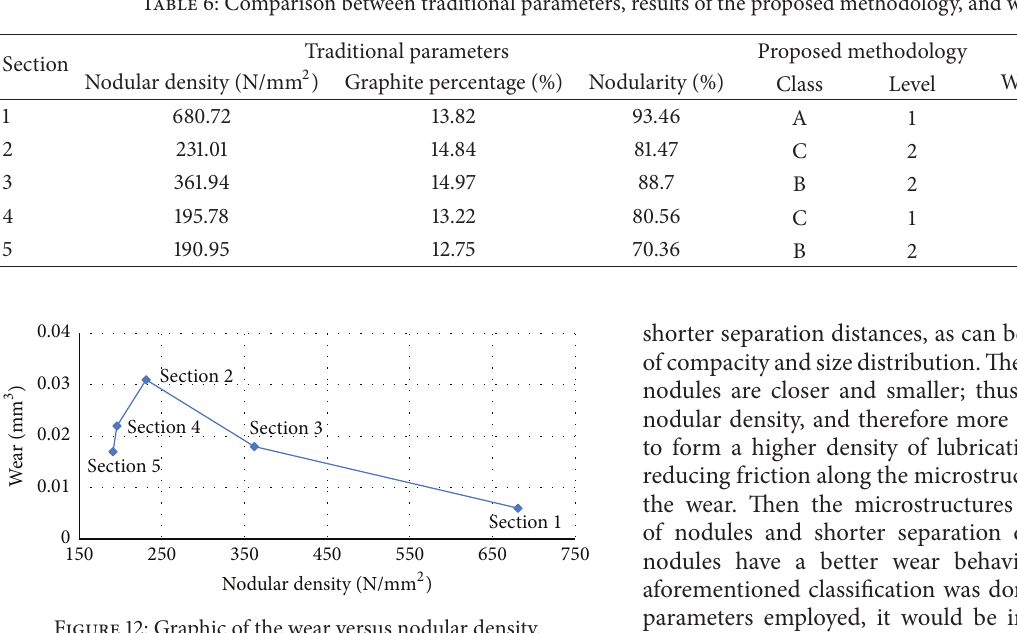
Table 6: Comparison between traditional parameters, results of the proposed methodology, and wear tests.